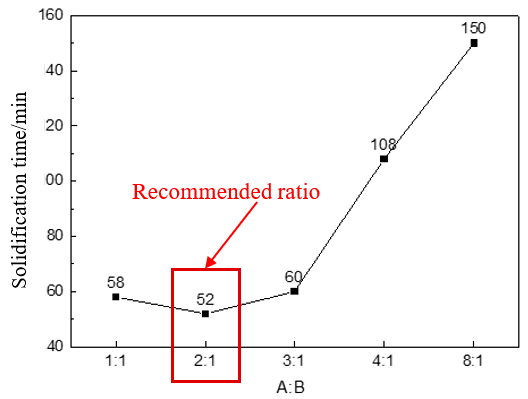
Figure 4. Solidification times with different ratios of group A and group B.